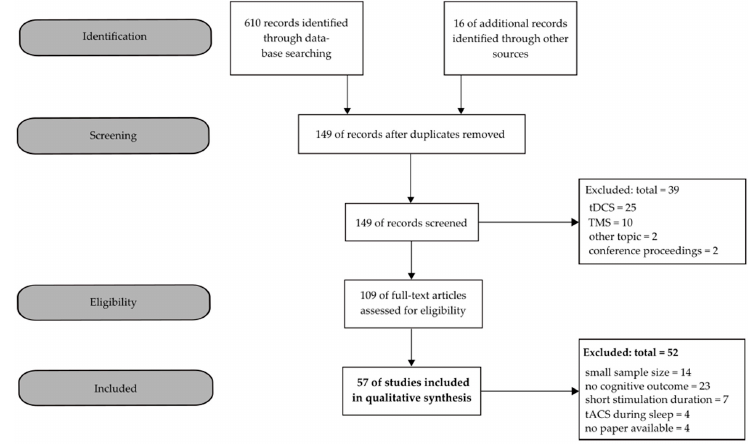
Figure 2. Flow chart of the identification and inclusion of studies in the current systematic